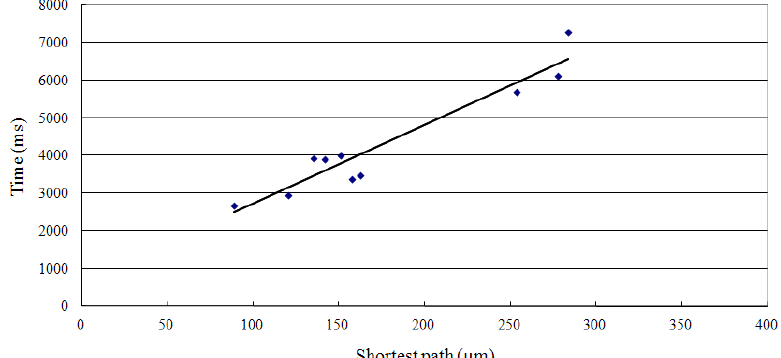
Figure 13. Relationship between the positioning time and the shortest path with voltage as the control factor.